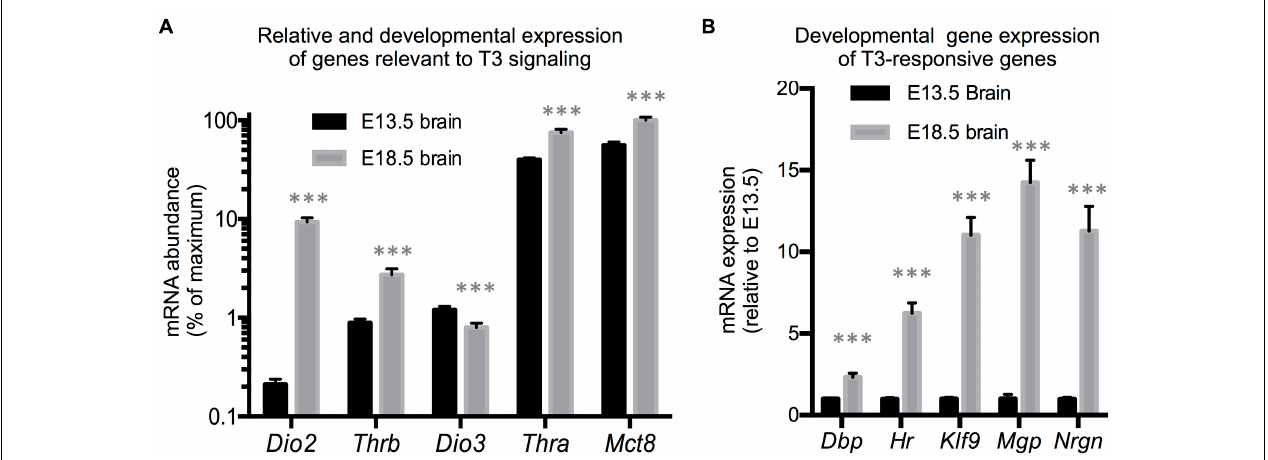
FIGURE 1 | E13.5 and E18.5 brain gene expression. (A) Developmental brain expression of genes that regulate T3 action. The relative abundance of mRNA between different genes is an estimation based on CT values on the assumption of similar annealing efficiency of primers used in real time qPCR. (B) Developmental brain gene expression of selected T3-responsive genes. Data represent the mean ± SEM of (A) eight different brains per experimental group representing both sexes and five different litters or (B) 8 (E13.5) and 11 (E18.5) different brains representing mice of both sexes and 6 (E13.5) or 8 (E18.5) litters. ∗∗∗ P < 0.001 E13.5 vs E18.5 as determined by the Student’s t